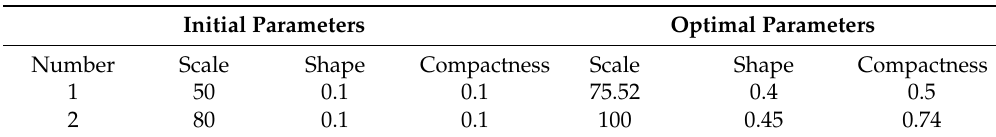
Table 3. Multi-resolution segmentation parameters. Table 3. Multi ‐ resolution segmentation parameters.